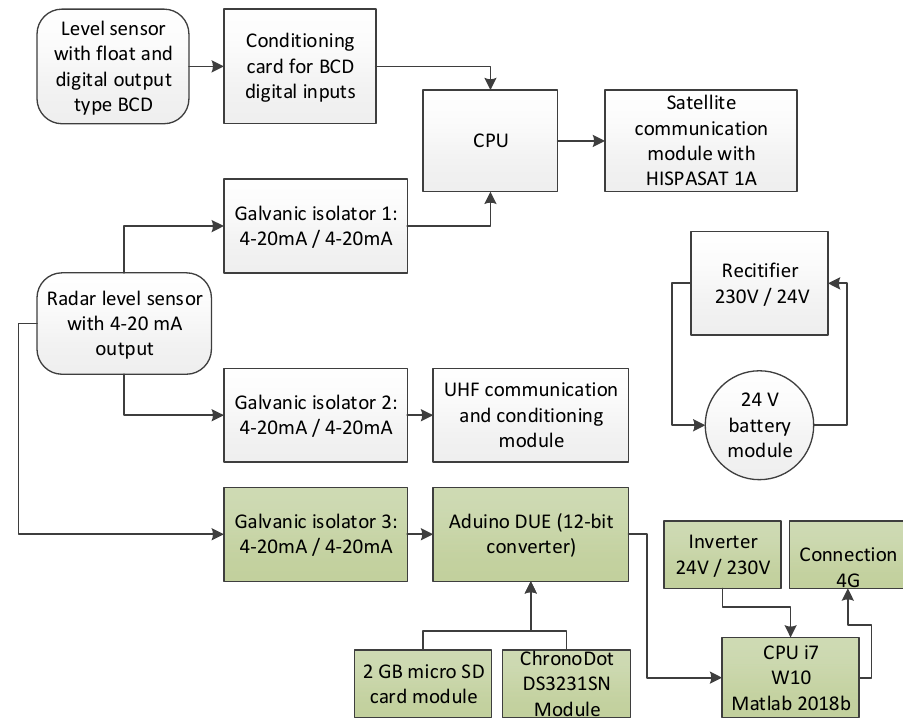
Figure 7. Block diagram of the SAIH system (SAINCO / Telvent) and the equipment developed